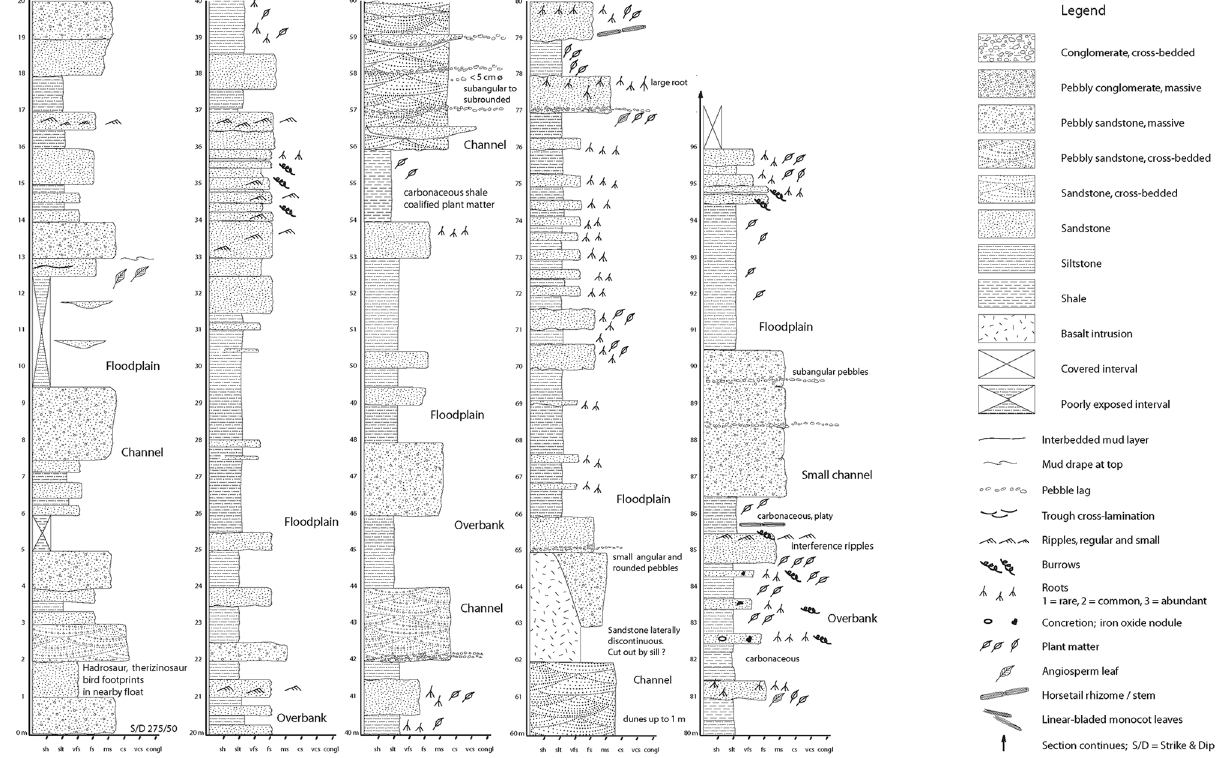
Figure 3. Measured stratigraphic section through the study area.